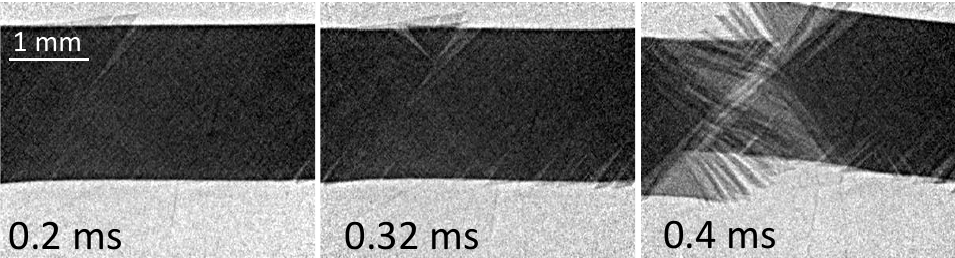
Figure 6. X-ray images of Basalt Fibre BFRP (fibre direction ± 45°) under tension in SHTB. Image series captured by Shimadzu HPV-x2 based ultra-high speed X-ray detector at 1 MHz frame rate (with 1060 ns inter-frame temporal sampling and captured with an exposure time of 200 ns) and a pixel count of 400 × 250 pixels for each of 128 acquired frames. From left to right, different timestamps capturing the formation of crack to fracture. White contrast in these radiographs represent high intensity X-rays. The aspect ratio of the images are adjusted for illustration purposes.